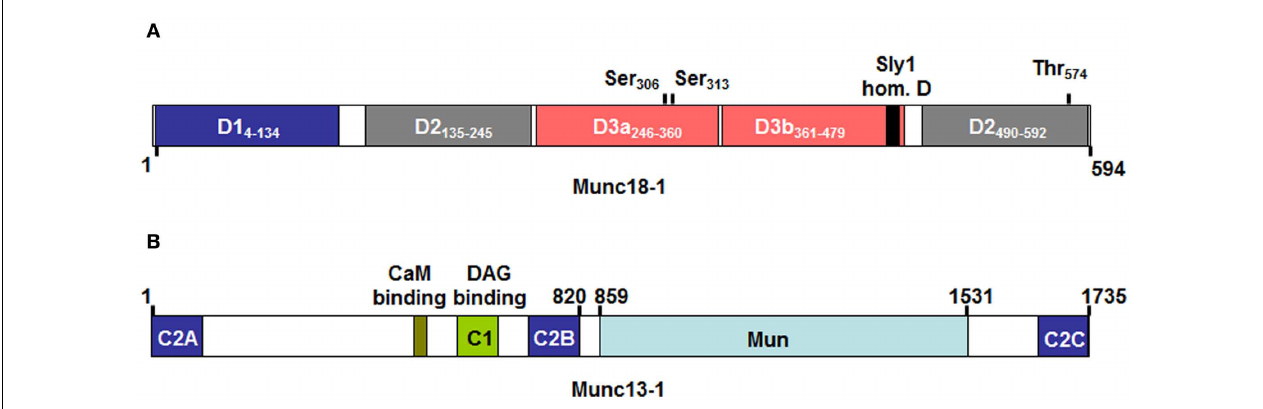
a Rab effector protein in yeast vesicular transport (Dascher et al., 1991). Above the domains are also indicated protein kinase C (Ser 306 and Ser 313 ) and Cyclin dependent kinase (Thr 574 ) phosphorylation sites that may regulate Munc18-1 effector functions. (B) The Munc13-1 protein contains several calcium-binding C2 domains, a Diacylglycerol (DAG) C1 domain making it responsive to stimulation with PKC as well as a calmodulin binding domain. Note that the ubiquitouisly expressed isoform 13-4, which is important in mast cell exocytosis lacks the N-terminal C2a, CaMb, and C1 domains.The Mun domain shows structural similarity to thethering proteins and may play a role in the transition of the closed conformation of STX molecules by contacting either Munc18 or STX molecules (Li et al., 2011; Sudhof and Rizo,